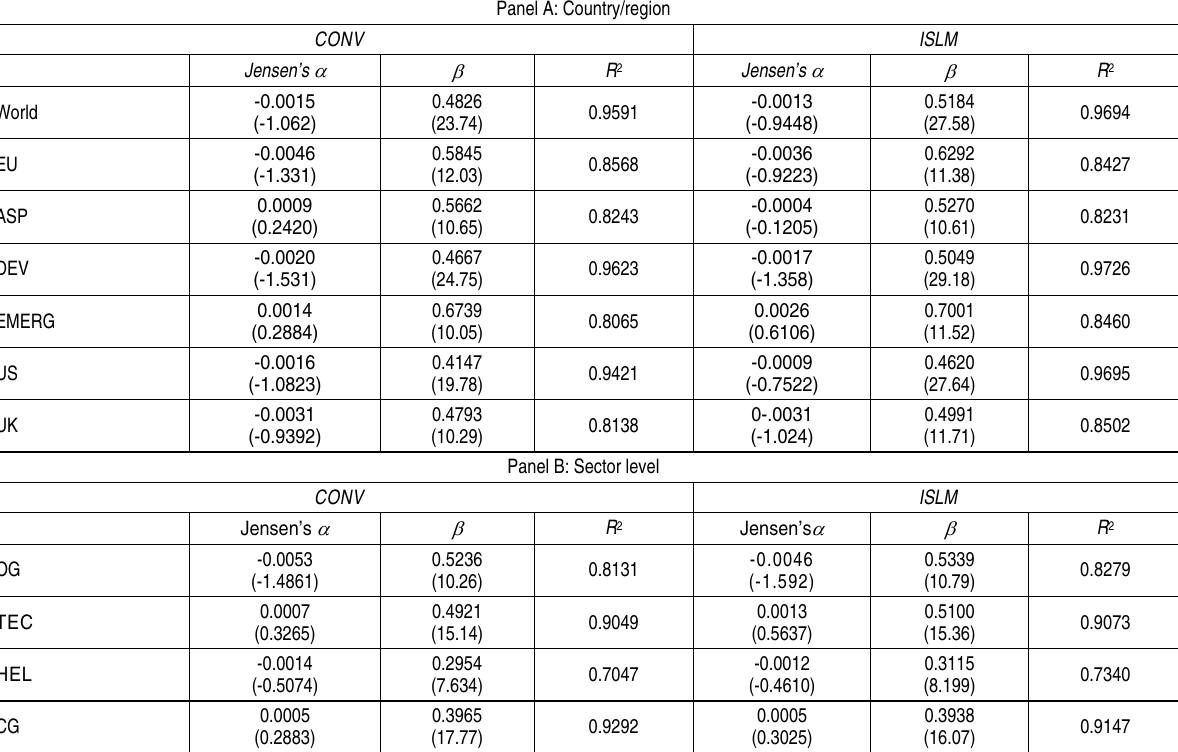
Table 11. CAPM Jensen’s α during financial